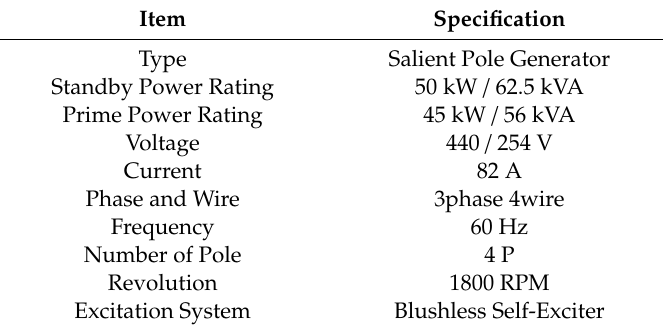
Table 4. Major specification of diesel generator.